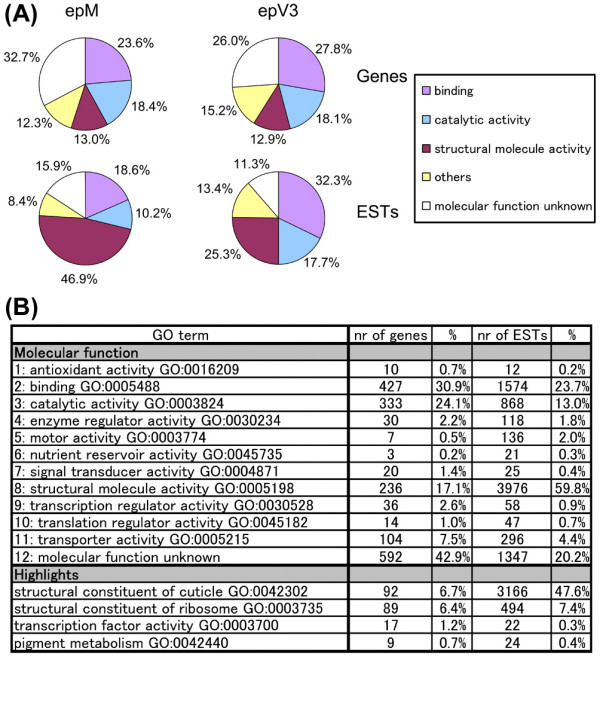
Assignment of Gene Ontology (GO) molecular function terms to the two epidermal EST data sets of Bombyx mori. (A) The ratio of gene numbers (upper) and total EST clones (lower) of the representative 4 GO terms are shown. (B) The ratio of genes classified into each GO term. The percentage of gene numbers (left) and total EST clones (right) were shown. Because one cluster can be associated with more than one GO term and total percentages summing all categories are shown as 100 in (A), percentage in (B) is different from that in (A). Highlights show the characteristic gene families such as cuticular proteins and transcription factors.